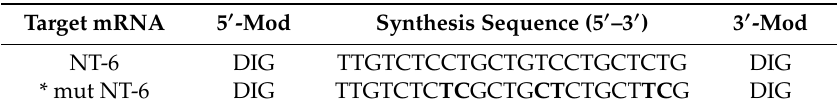
Table 1. LNA probe and mismatch